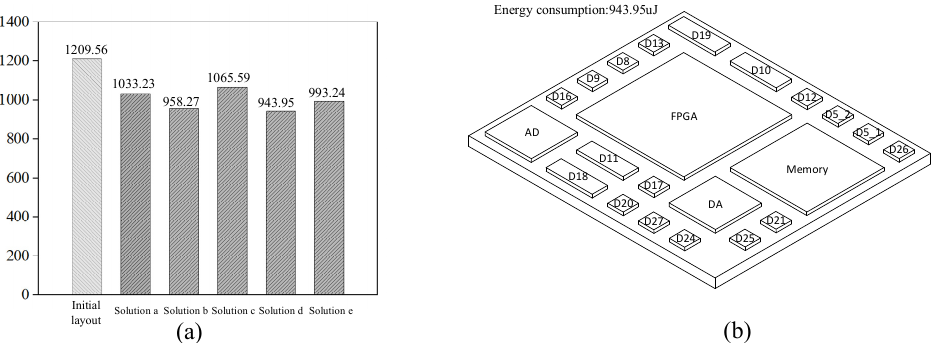
Figure 10. ( a ) Contrast of initial layout and CCEOA results; ( b ) 3D schematic diagram of the opti- mal result.